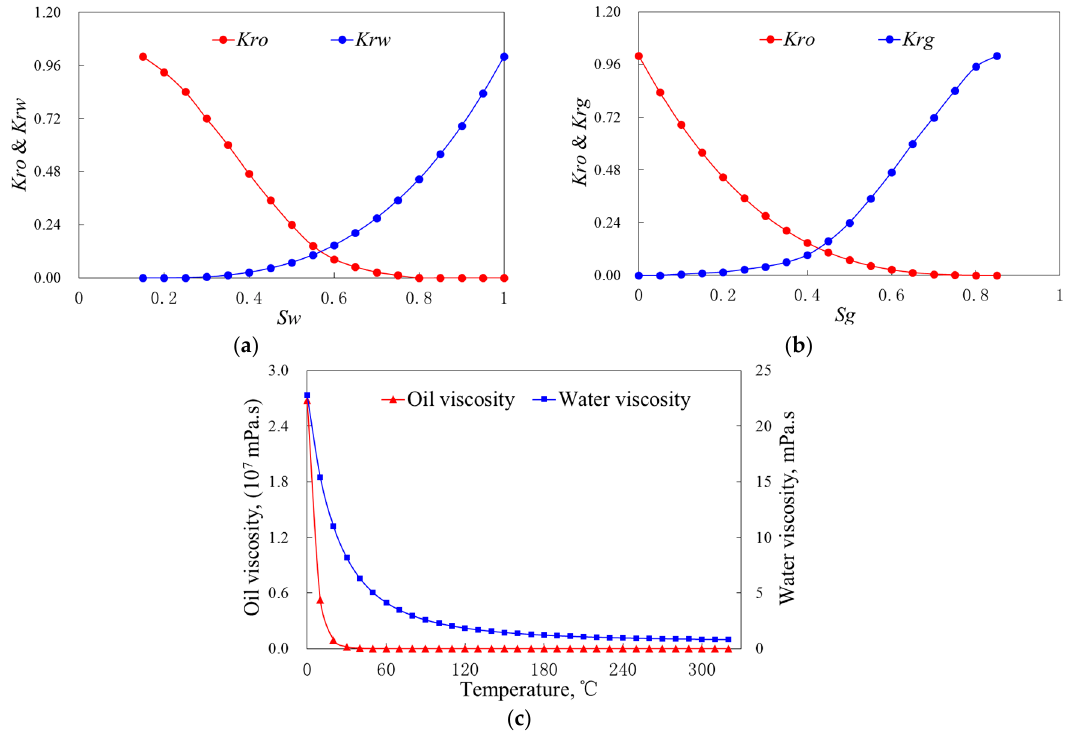
Figure 6. Relative permeability curve and viscosity vs. temperature: ( a ) Relative permeability curves of oil and water; ( b ) Relative permeability curves of oil and gas; ( c ) Viscosities of oil and water. Energies 2020 , 13 , x FOR PEER REVIEW